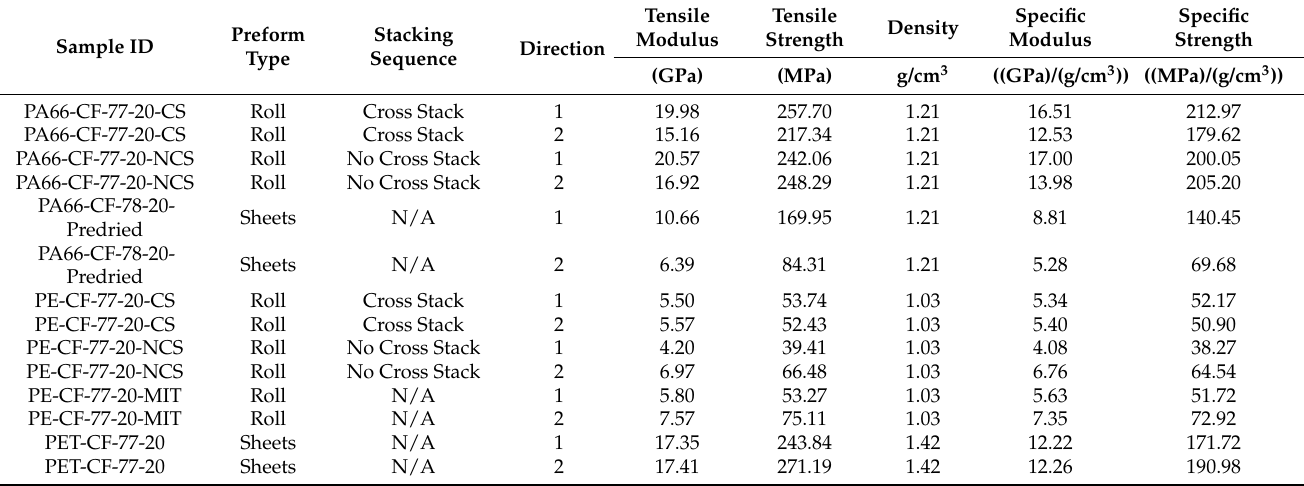
Table 12. Comprehensive summary of tensile strength, tensile modulus, specific strength and specific modulus for all rCF variants in this study. The effect of stacking sequence and ‘roll’ versus ‘sheet’ form are